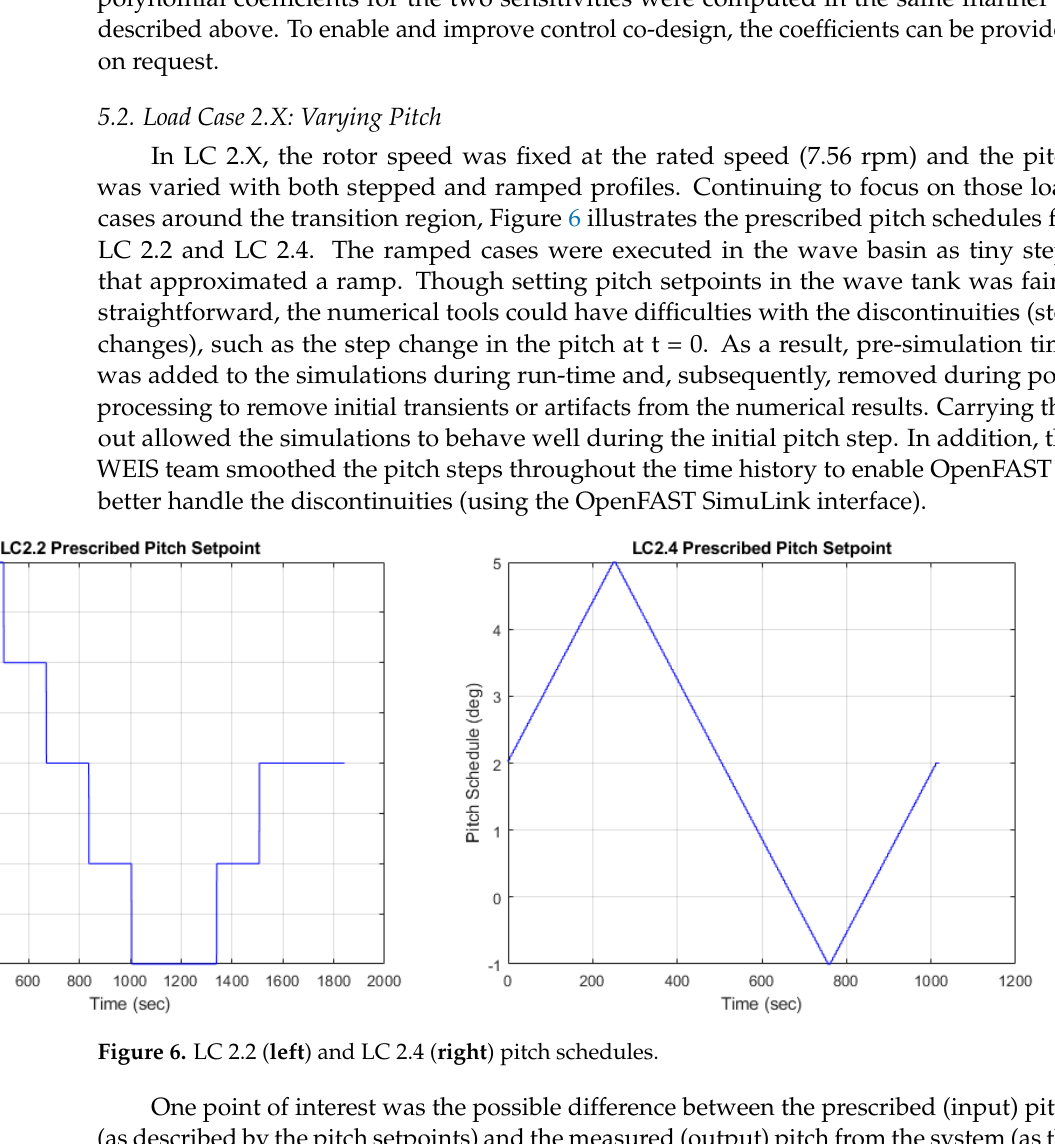
13 of 25 Figure 5. LC 1.1 tower top forces and moments, blade root bending moments. The results for LC 1.2, which was similar to LC 1.1, but with a pitch of 10°, were discussed here, but no summary plots were shown. The overall trends and magnitudes between the numerical and experimental results for the thrust, torque, and tower top forces and moments matched well. Similarly, the numerical results for the flap-wise and edge-wise blade root bending moments were quite close; most of the differences ranged between ~0–20% and ~0–40%, respectively. The primary difference in the post-processing of the LC 1.2 results was that a second-order polynomial was used to fit the limited exper- imental data (note that experimental results were limited to rpm = 3–6) and, subsequently, differentiated to yield the derivatives of thrust and torque with respect to the rotor speed. The numerical polynomial coefficients for the two sensitivities were computed in the same manner as described above. To enable and improve control co-design, the coefficients can